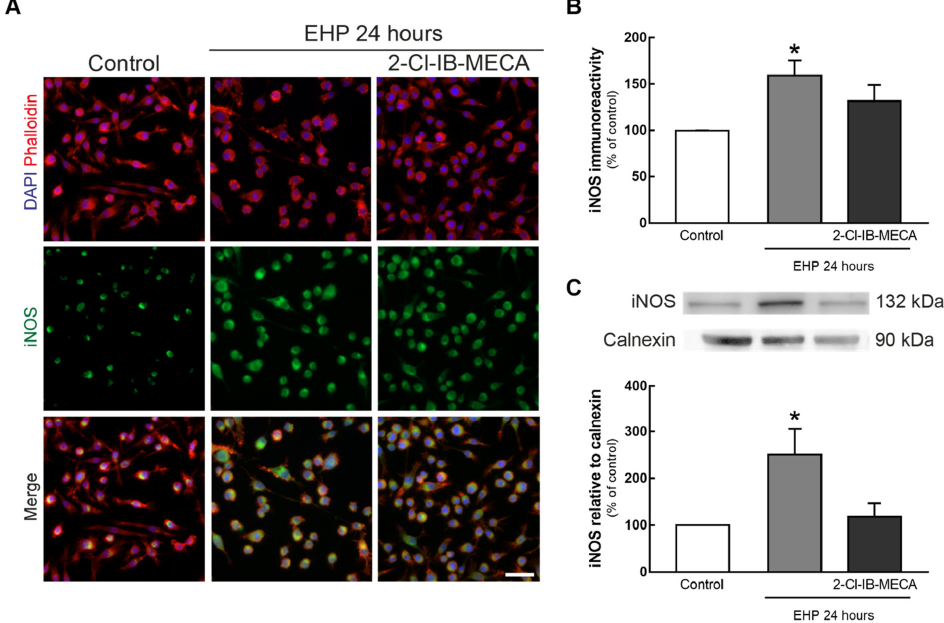
Figure 2. Effect of A 3 R activation in the immunoreactivity and protein levels of inducible nitric oxide synthase (iNOS) in BV-2 cells challenged by EHP. BV-2 cell cultures were incubated with 1 µM 2-Cl- IB-MECA followed the exposure to EHP for 24 h. ( A ) Representative images of microglia labeled with phalloidin (red) and iNOS (green). Nuclei were stained with DAPI (blue). Scale bar: 40 µm. ( B